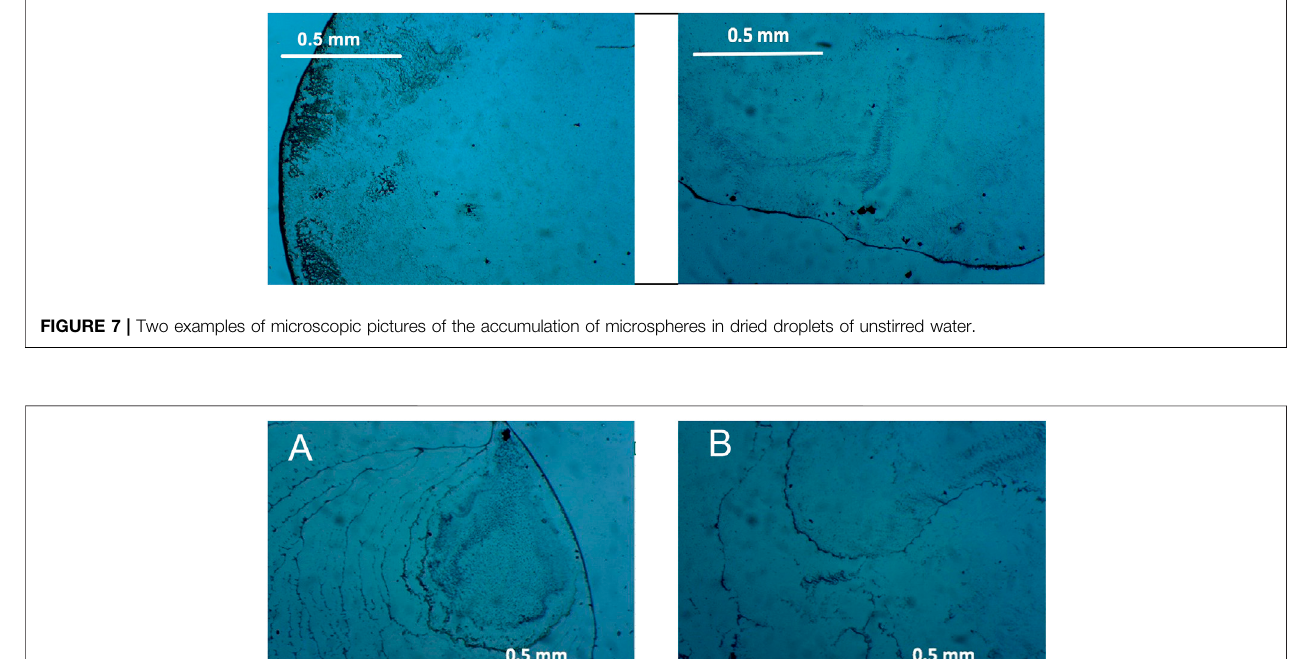
dilutions and water “ dilutions ” in the presented here images in Figure 10 : upper row vs. lower row (10 – 19 M) and Figure 12 : upper row vs. lower row (10 – 31 M). In a number of cases, certain structuring in the distribution of microspheres was also found in some drops from the control water “ dilutions ” but the appearance of structures was different from those typical for the respective HyFn dilutions.